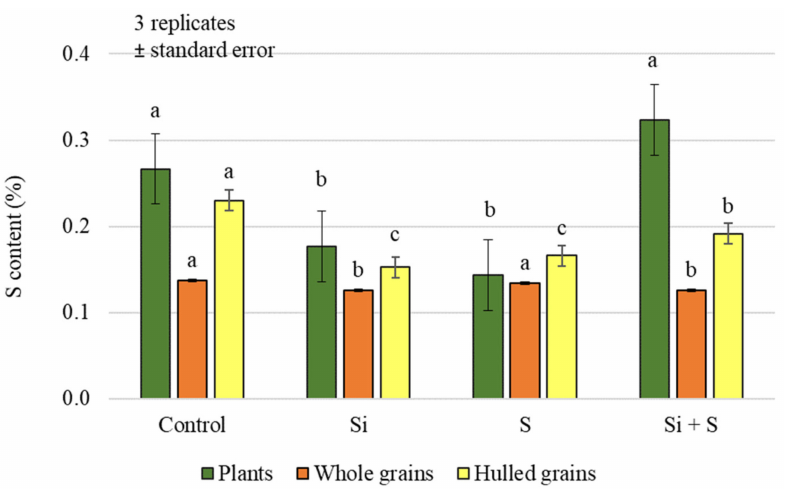
Figure 5. Sulphur content of the winter oat plants, and whole and hulled grains, as a function of foliar fertilisation treatments; ± standard error of means. 3 replicates. The different letters indicate significant differences between the treatments, separately in different plant samples, at p = 0.05